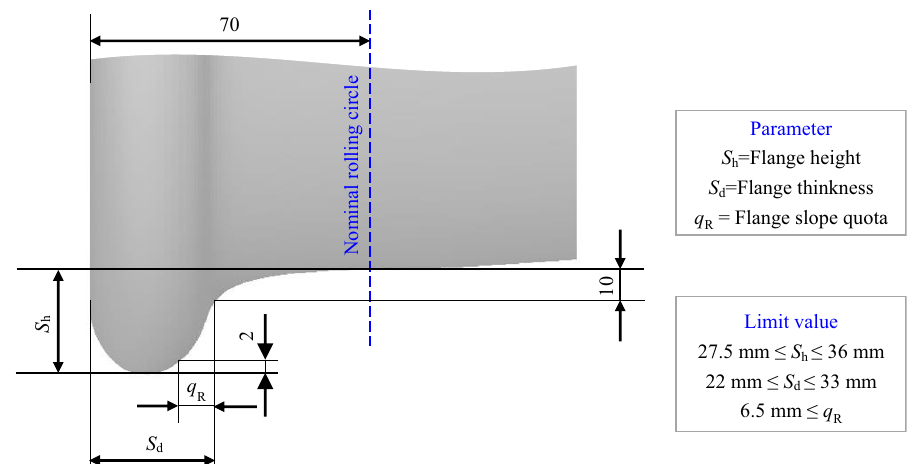
Fig. 7 Three parameters for evaluating wheel wear as well as their limits for a 1250-mm-diameter-wheel specified